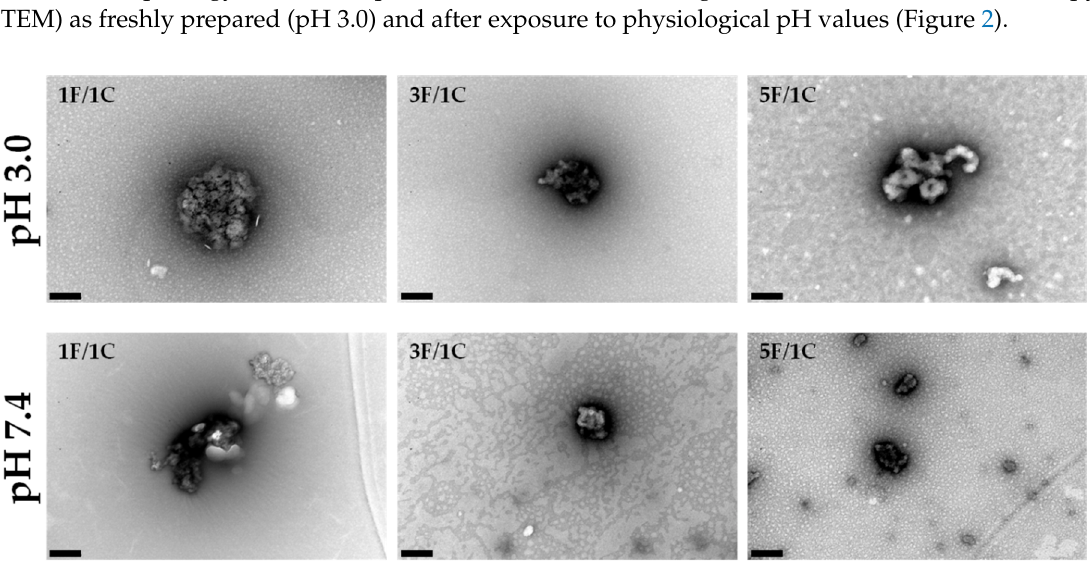
Figure 2. Fucoidan/chitosan nanoparticle morphology. Transmission electron microscopy (TEM) images obtained for the nanoparticles 1F/1C, 3F/1C, and 5F/1C. Scale bar = 200 nm.